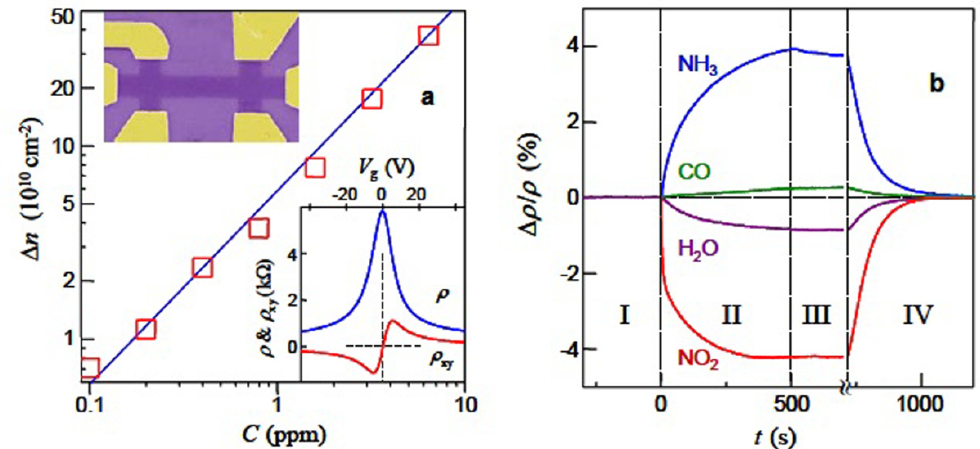
Figure 1. Sensitivity of graphene to chemical doping. ( a ) Concentration ∆ n of chemically-induced charge carriers in single-layer graphene exposed to different concentrations of NO 2 . Upper inset: scanning-electron micrograph of this device. The scale of the micrograph is given by the width of the Hall bar, which is 1 µm. Lower inset: Characterization of the graphene device by using the electric field effect; ( b ) Changes in resistivity ρ caused by graphene’s exposure to various gases diluted in concentration 1 ppm. The positive (negative) sign of changes is chosen here to indicate electron (hole) doping. Region I—the device is in vacuum prior to its exposure; II—exposure to a 5 liter volume of a diluted chemical; III—evacuation of the experimental setup;